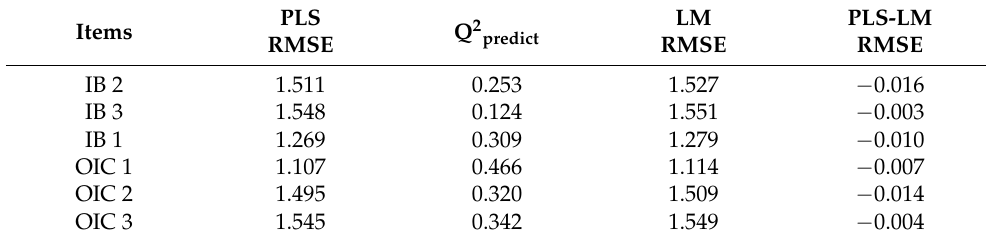
Table 3. Manifest variables and their PLS